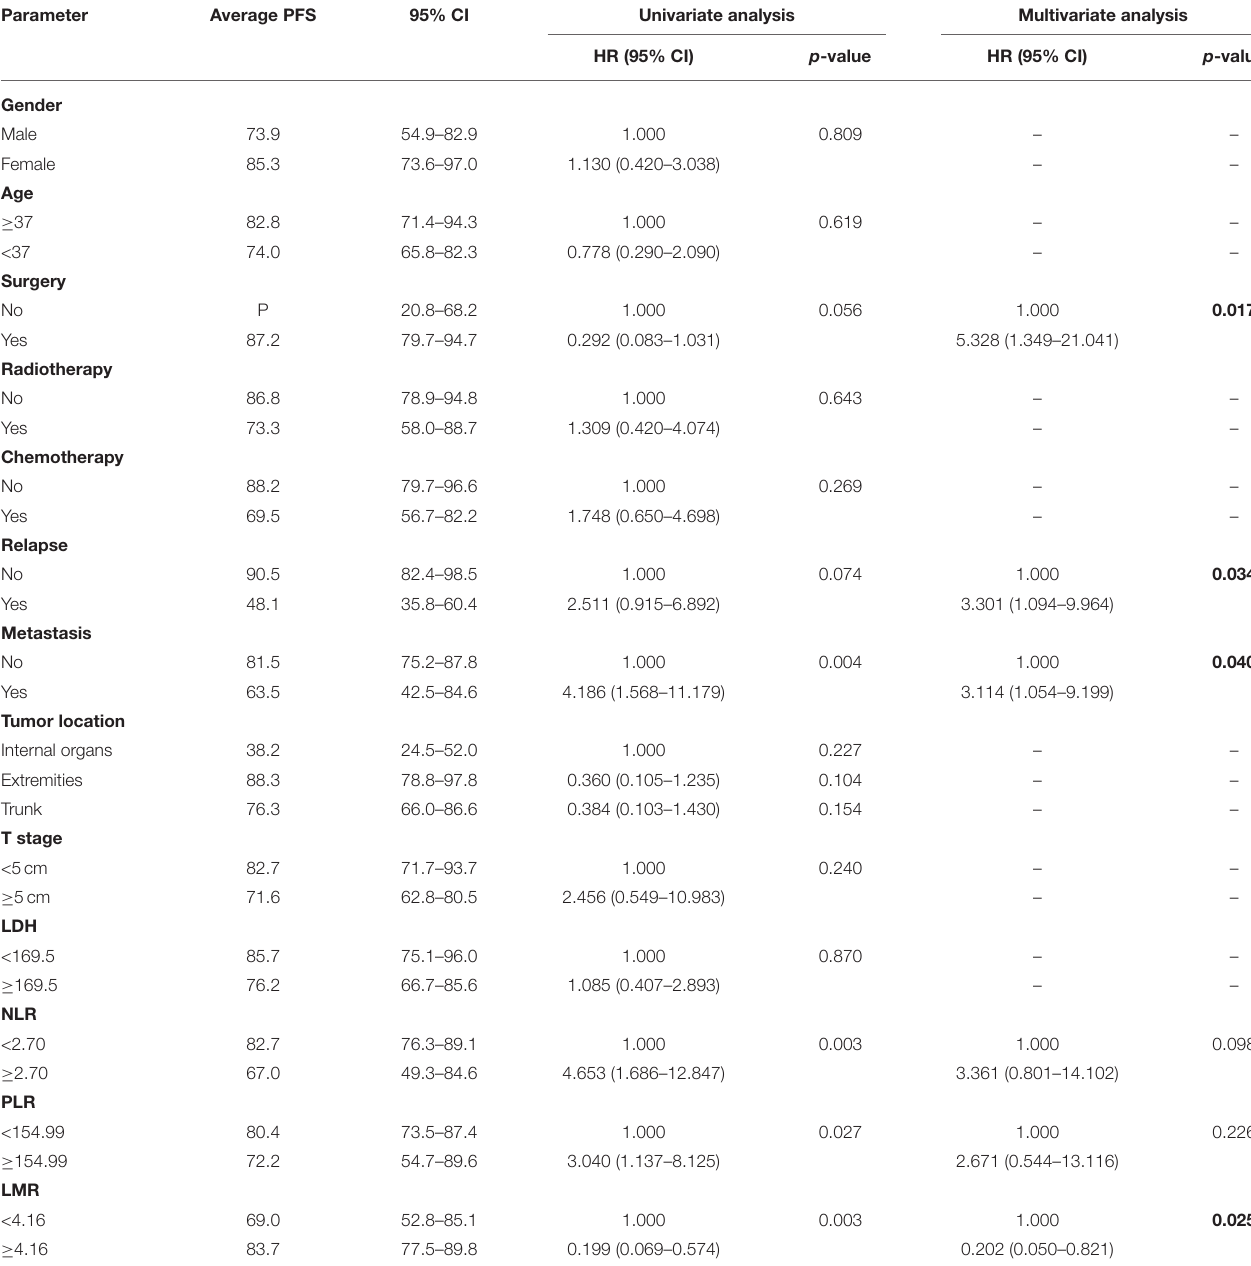
TABLE 3 | Summary of univariate and multivariate analysis for PFS in patients with synovial sarcoma.